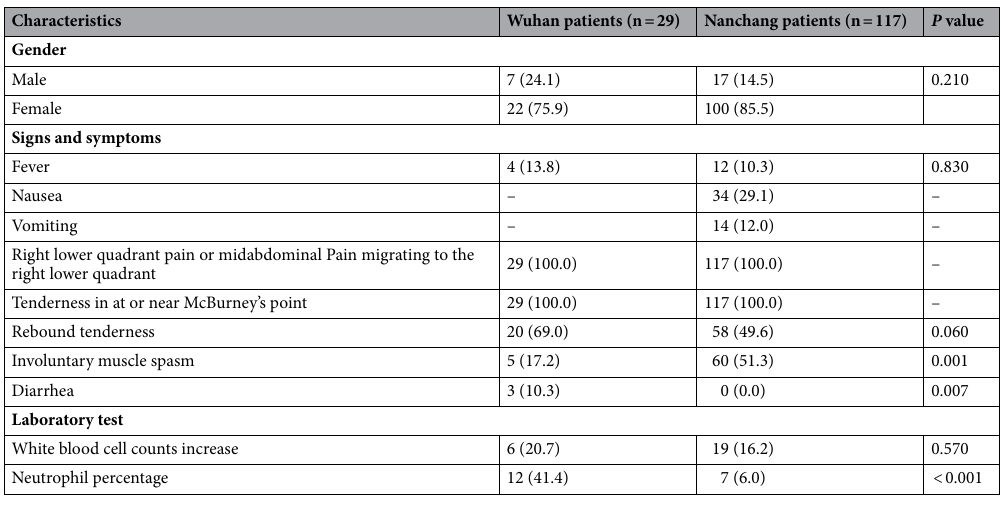
Table 1. Clinical and laboratory features of Tibetan and Wuhan clustered patients. Categorical variables were compared by the χ 2 test or Fisher’s exact test was used when the data were limited. A 2-sided α of less than .05 was considered statistically